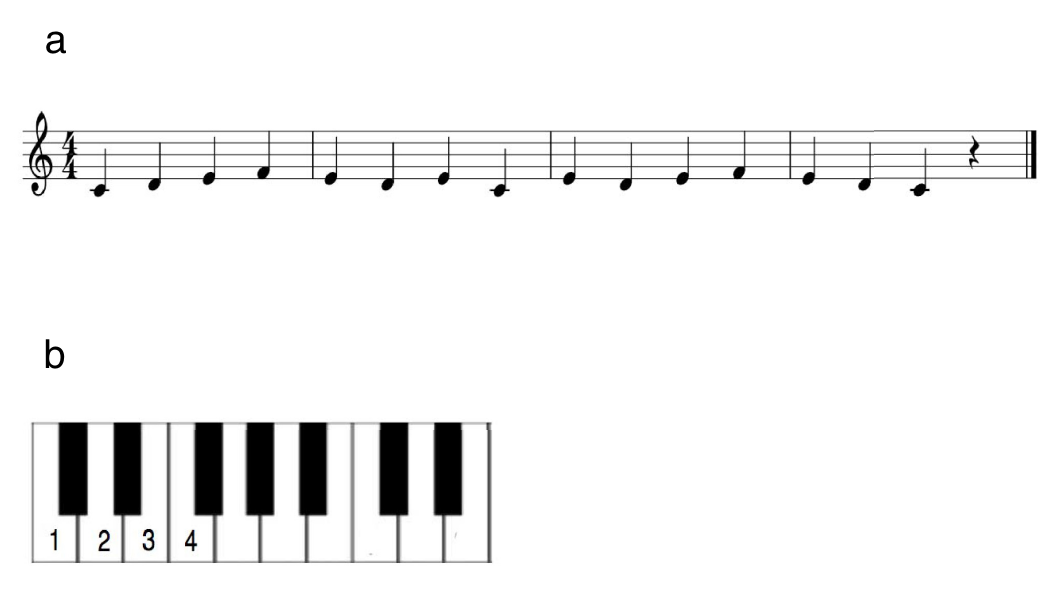
Fig 1. a: The musical sequence played by the non-musician participants. b: Visual template on which the image of the piano keyboard was depicted and the finger placements were marked. Numbers represent the fingers (thumb, 1; index finger, 2; etc) with which the participants were supposed to press the corresponding piano